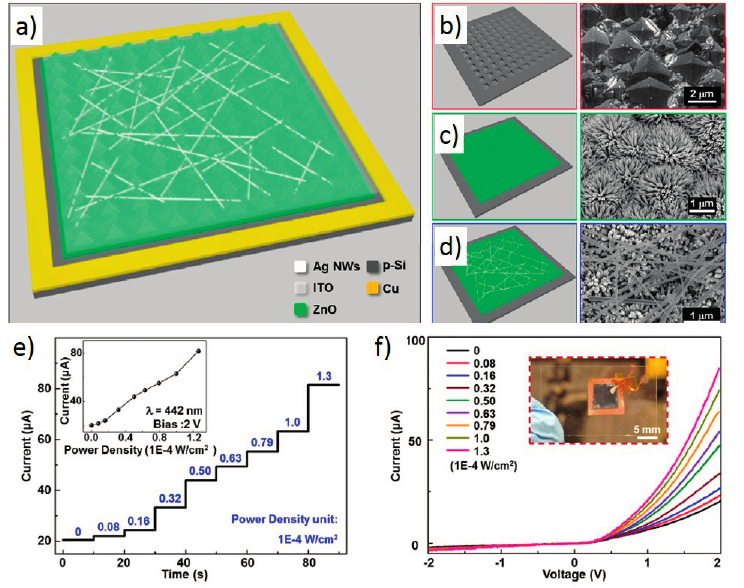
Figure 9. Device fabrication and its performance without strain. ( a ) Schematic structure of a p-Si/n-ZnO nanowire hybridized photodetector; ( b – d ) Schematic structure (left panel) and SEM images (right panel) of ( b ) etched Si wafer and n-ZnO heterojunction ( c ) before and ( d ) after spin coating silver nanowire; ( e ) I-t response of the device under different illumination power densities at 2 V bias voltage. The inset shows the current change with power densities; ( f ) I-V characteristics of the device under different illumination power densities when a triangle wave is applied. The inset shows the real device. Adapted from [81] with permission from American Chemical Society. Copyright